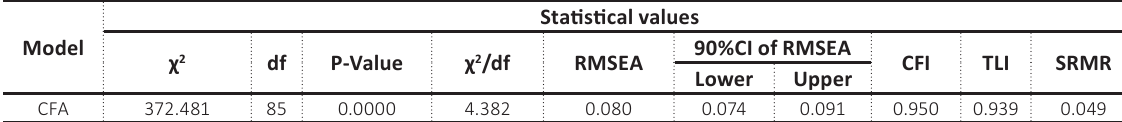
Figure 2. CFA Table 1. Statistic value for assessing the harmony of the CFA model